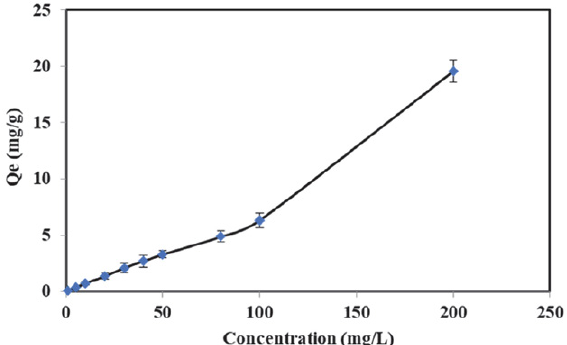
Figure 6. Three-dimensional surface plots in CCD optimization procedure. (a) Effects of pH and contact time, ( b) Effects of pH and temperature (T), (c) Effects of contact time and volume of sample (V s ).